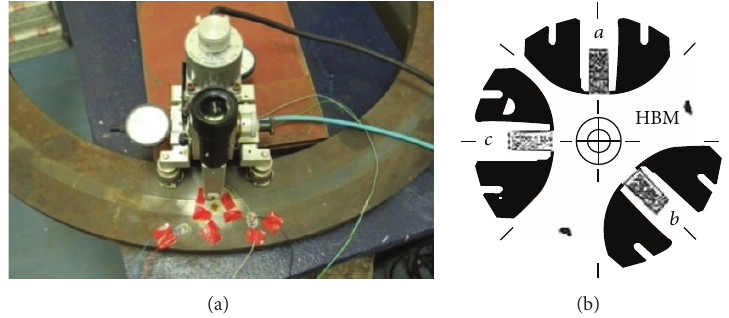
Figure 3: (a) Strain gauge rosette attached on the hardfaced surface. (b) Strain gauge rosette used.